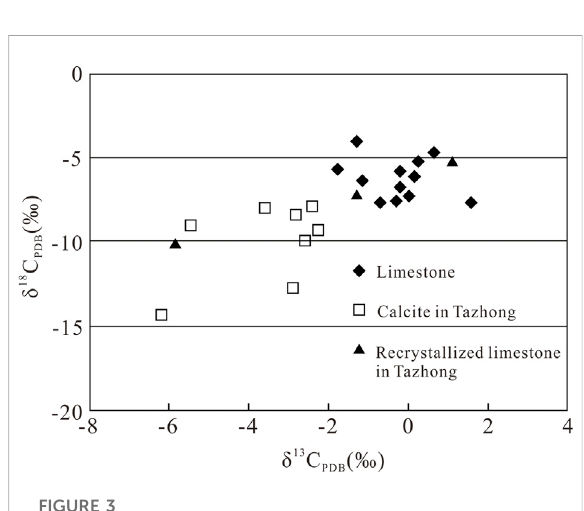
FIGURE 3 δ 18 OPDB- δ 18OPDB relationship of Ordovician calcites in the Tarim